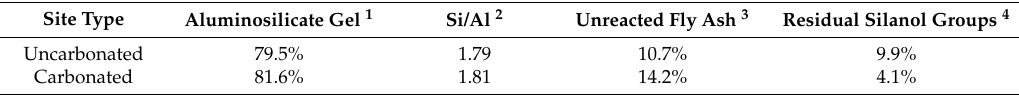
Table 2. Phase composition of uncarbonated and carbonated alkali-activated fly ash as derived from deconvolution